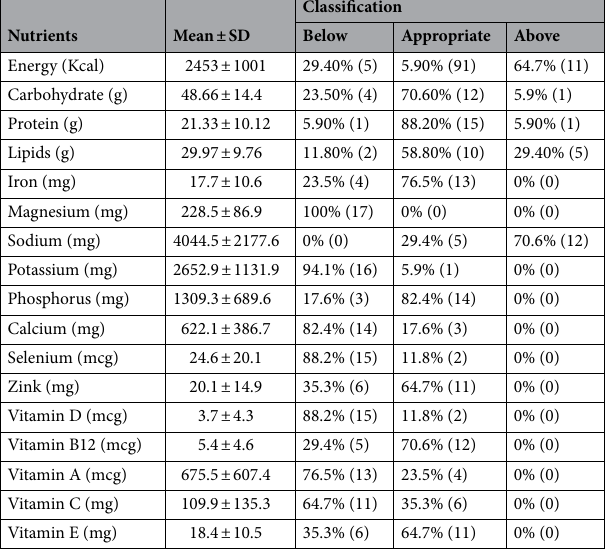
Table 3. Consumption mean and standard deviation, percentage, and number of patients classified according to the need for energy, carbohydrate, protein, and lipid variables according to ASPEN 23 and micronutrients according to the DRIs 24 . Descriptive analysis. % percentage, SD standard deviation.